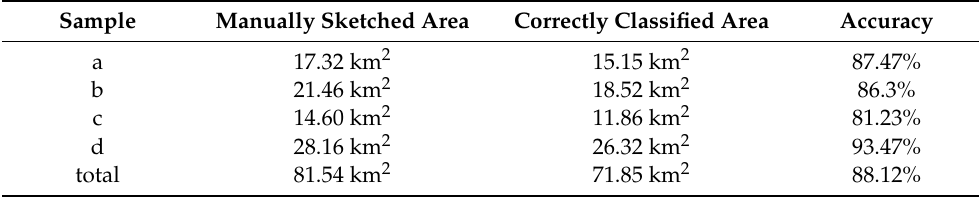
Table 4. Evaluation results of loess landform classification